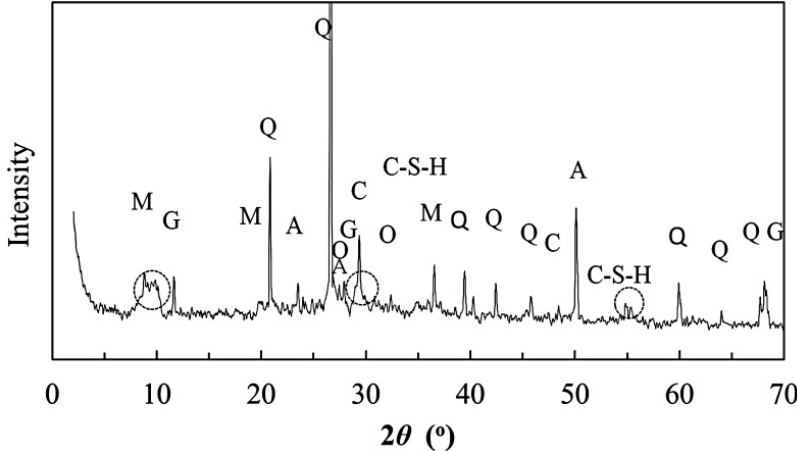
Figure 3. The XRD pattern of the powder matrix sample. ( Q : Quartz, M : Muscovite, O : Orthoclase, A : Albite, G : Gypsum, and C : Calcite).